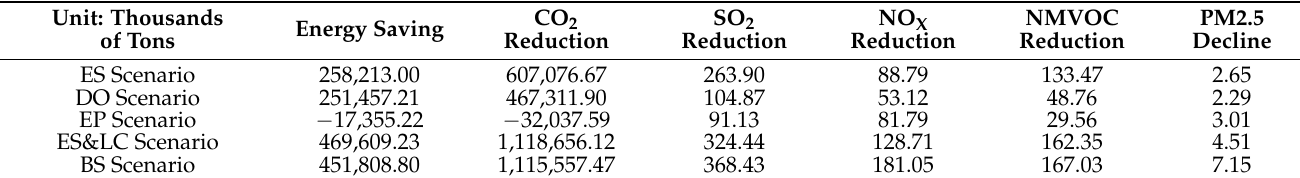
Table 4. The cumulative amounts of energy saving and emission